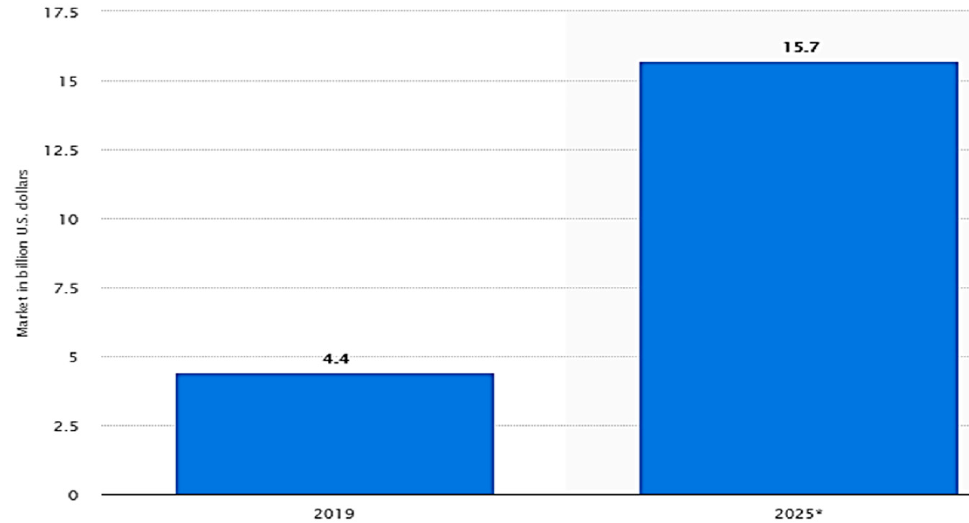
Figure 1. Statistical data about the use of the vertical farming market in the world.